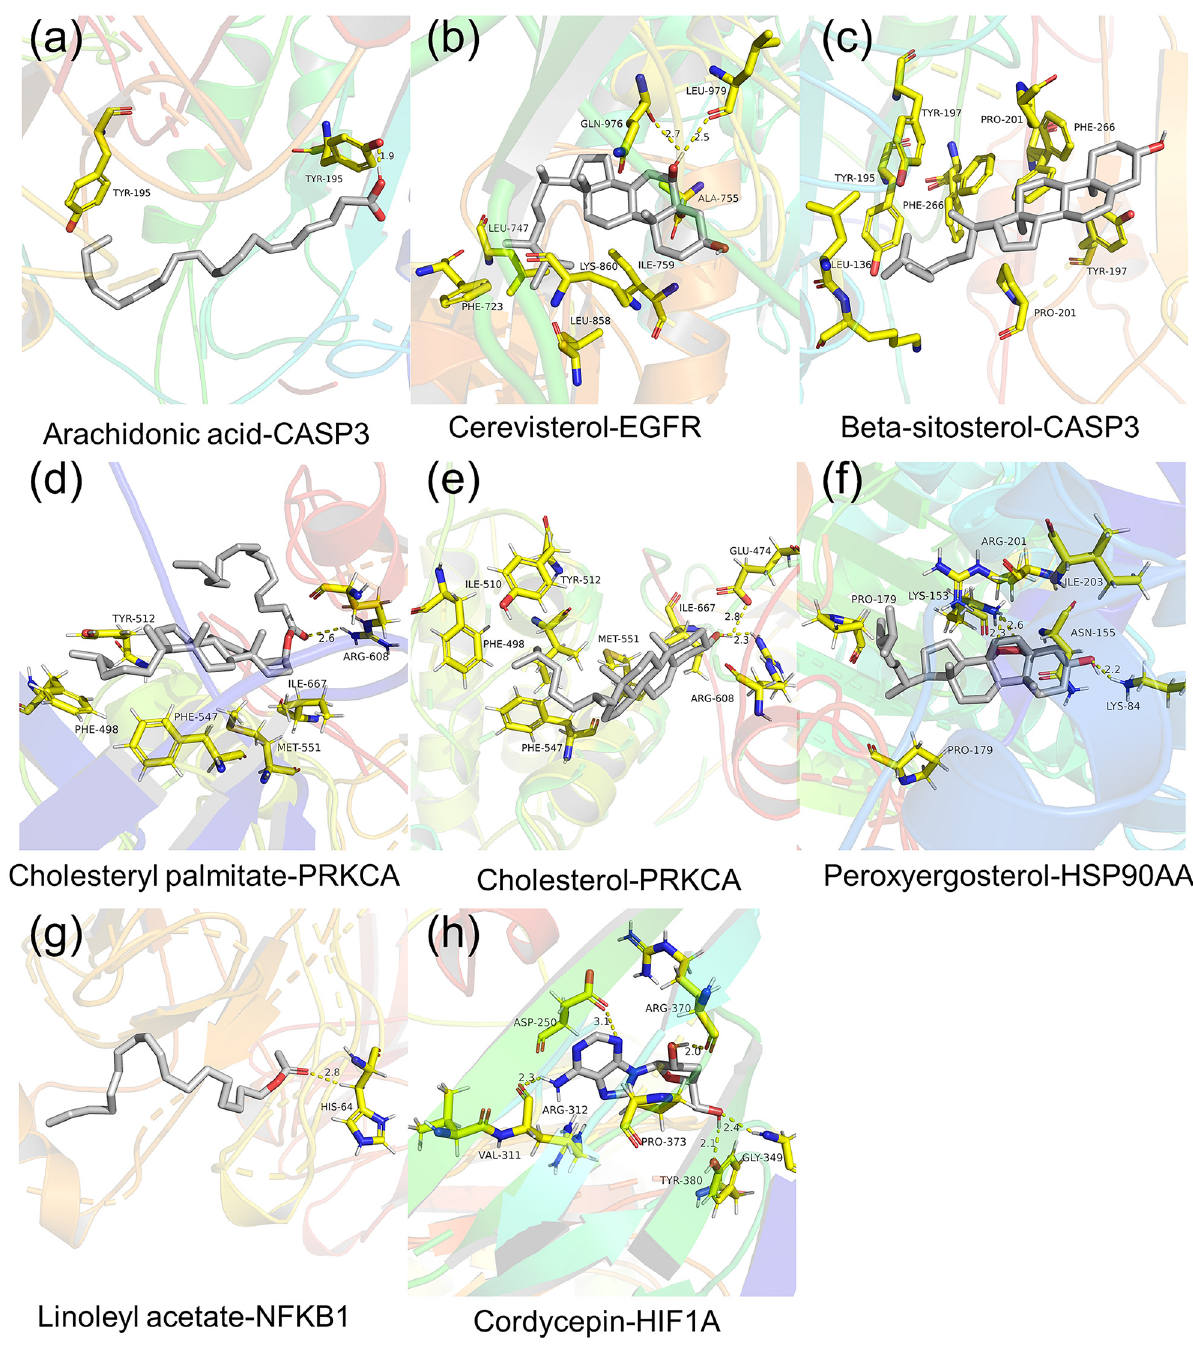
Figure 8: The protein – ligand of the docking stimulation. ( a – h ) Docking between eight active components and their possible optimal targets. The yellow dotted line represents hydrogen bond; the number represents hydrogen bond distance; the gray stick structure represents the active small molecules, and the yellow stick structure represents amino acid